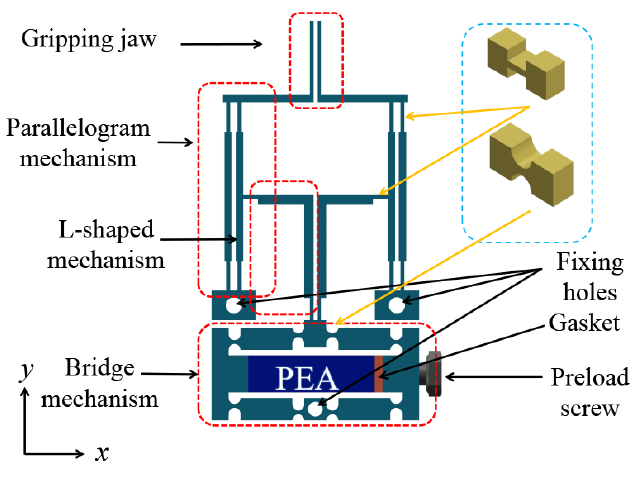
Figure 1. Computer-aided-design (CAD) model of the designed